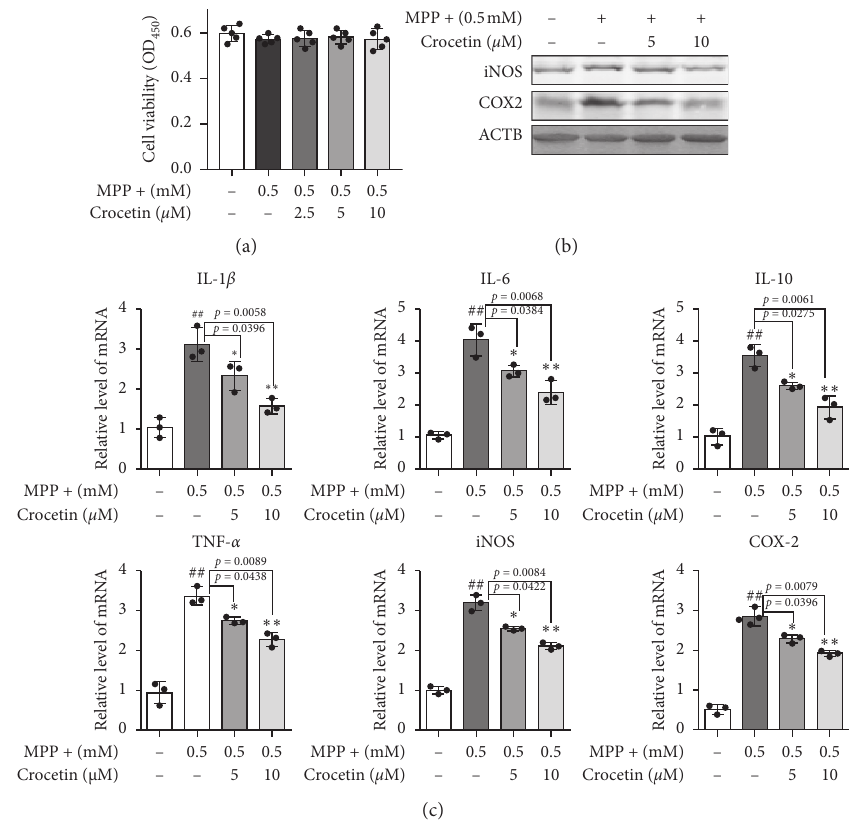
Figure 3: Crocetin inhibits MPP+ induced inflammation in BV2 cells. BV2 cells were treated with 0.5mM MPP+ for 6h, and then 2.5 μ M, 5 μ M, and 10 μ M crocetin were added and incubated for another 24h. (a) Cell viability was determined using the CCK-8 assay. (b) The protein level of iNOS and COX-2 were measured using Western blot. (c) After different stimulation, the mRNA level of IL-1 β , IL-6, IL-10, TNF- α , iNOS, and COX-2 in the BV2 cells was measured using RT-qPCR. Data are expressed as the mean ± standard deviation, and statistical analysis was performed using a one-way analysis of variance followed by Tukey’s post hoc test. ## P < 0 . 01 versus control; ∗ P < 0 . 05, ∗∗ P < 0 . 01 versus